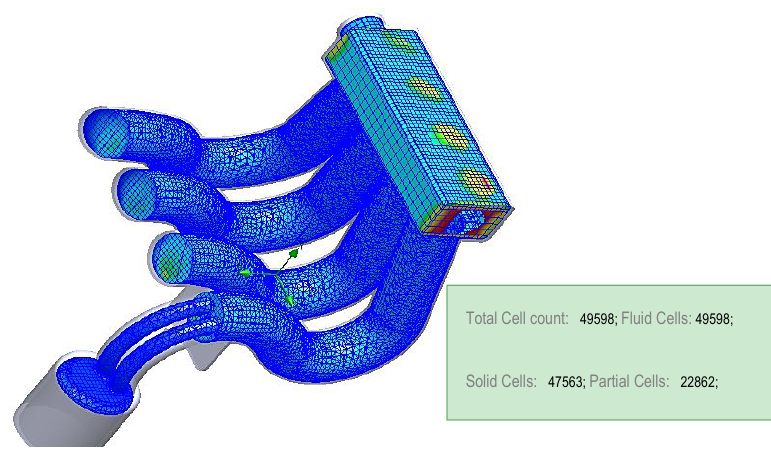
Figure 6. Computational meshing.